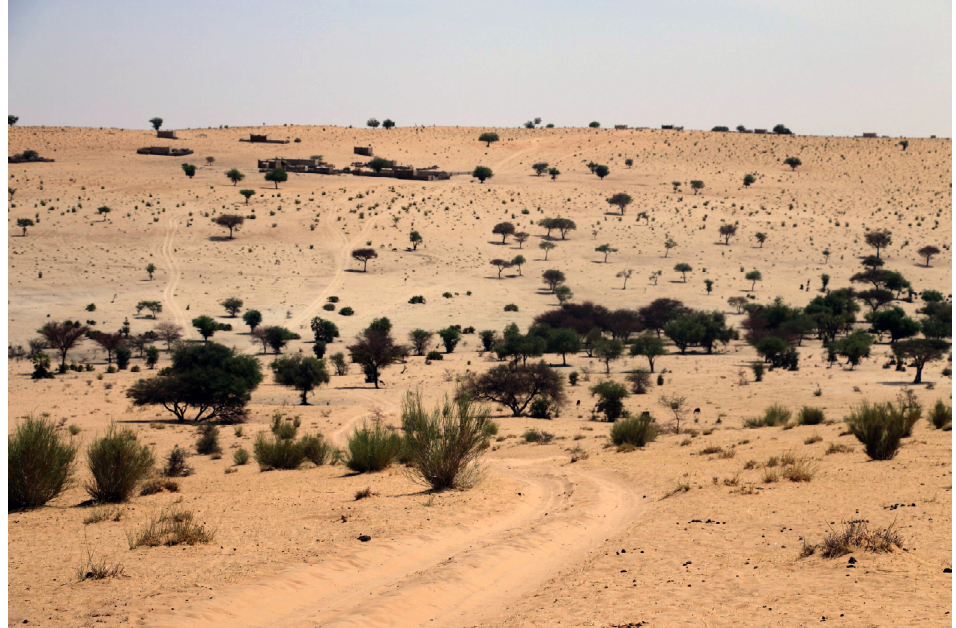
Figure 6. Sahel region in the south of Mauritania, typical habitat of the new species.